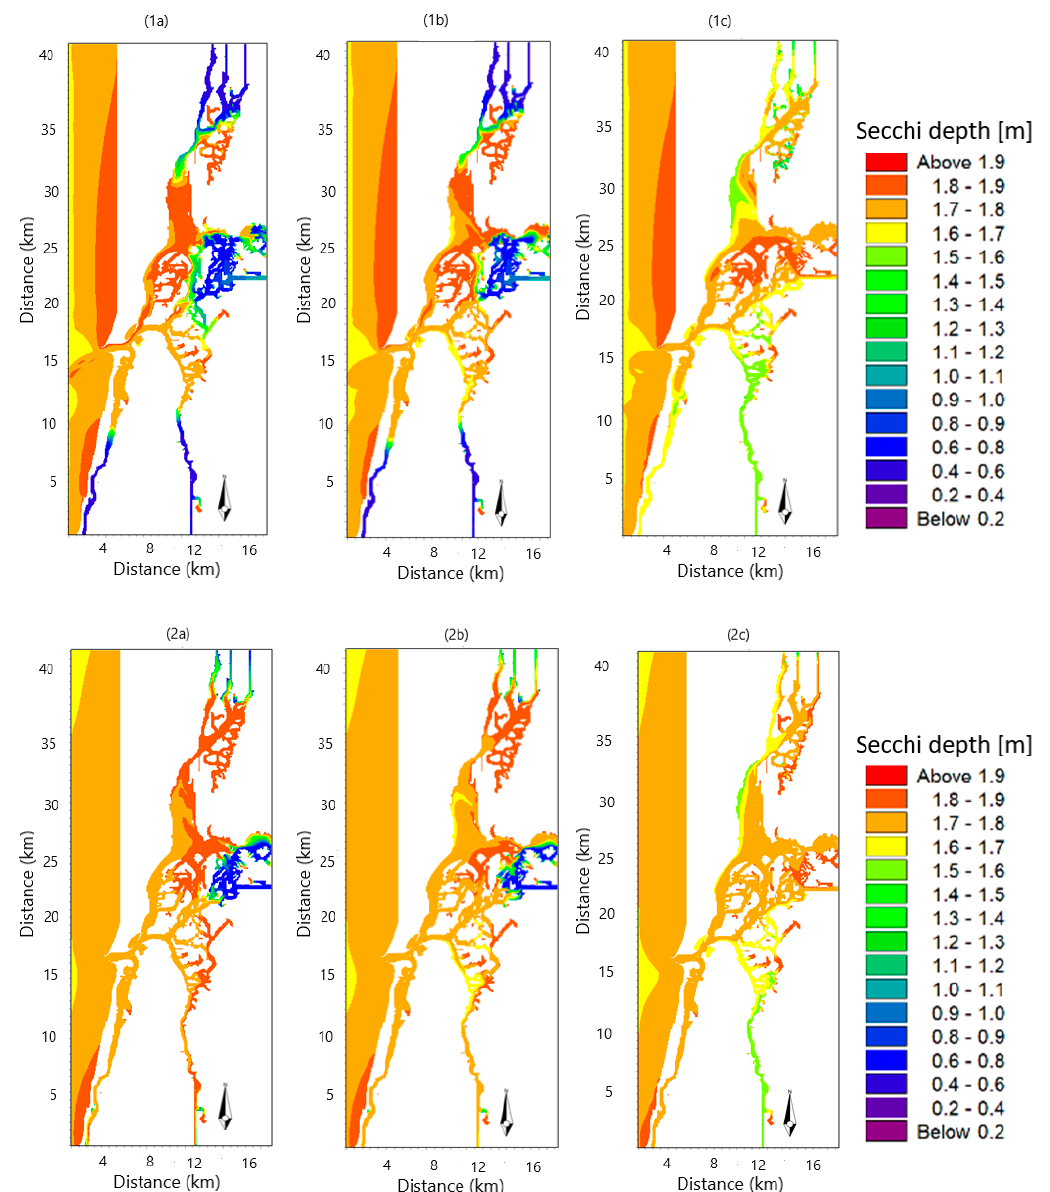
Figure 14. Snapshots of Secchi depth, ScD, for BS ( a ), SC1 ( b ), and SC2 ( c ), for two instants: 1—high tide, flooding at the lagoon mouth and ebbing at the mouth of the rivers (17/9/2000); 2—high tide, ebbing at the lagoon mouth and flooding at the mouth of the rivers (27/9/2000).